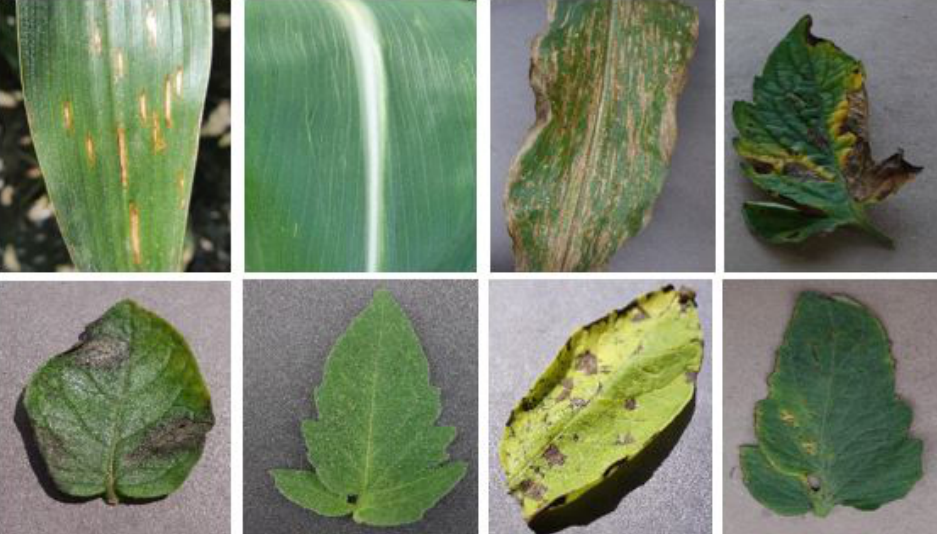
Figure 4. Sample images of the diseased and healthy